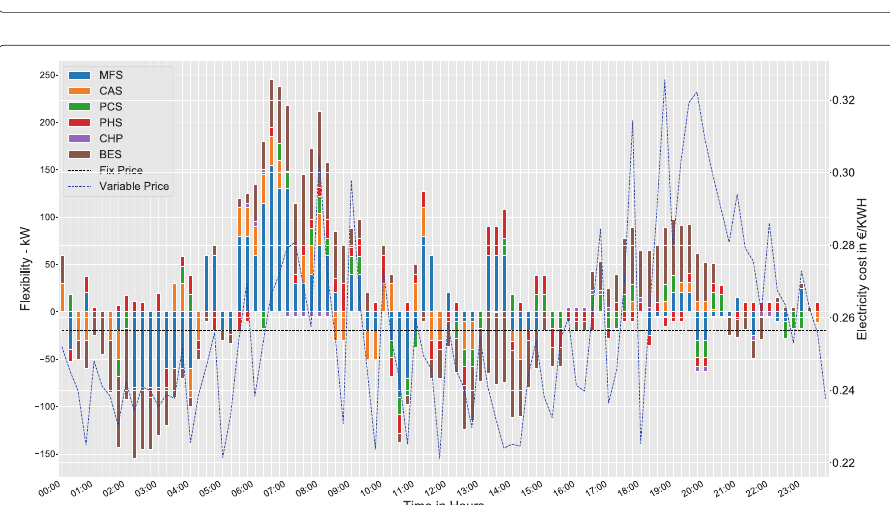
Fig. 11 Breakdown of the flexibility provided by each system in response to the variable electricity